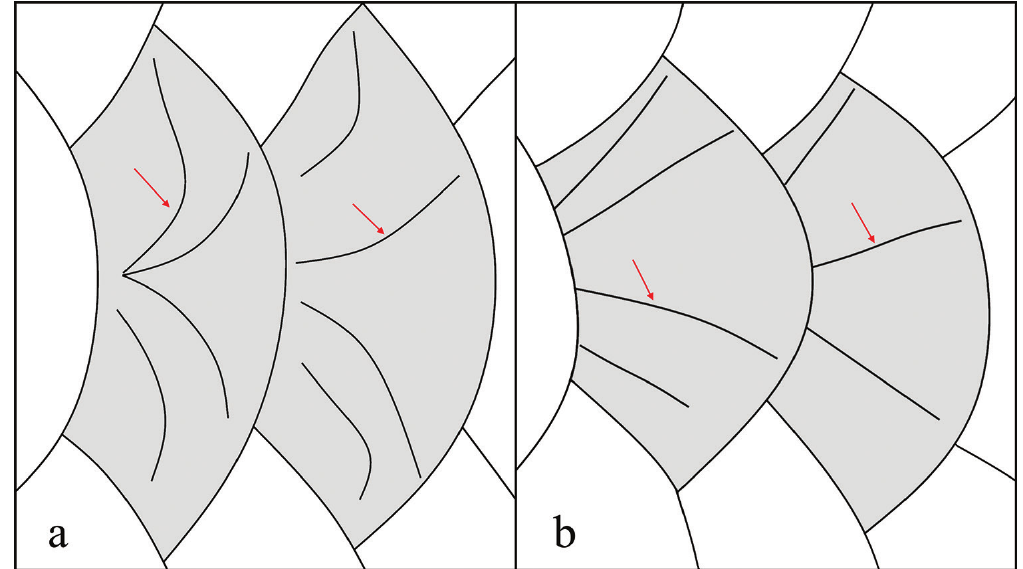
Figure 2. Ilustration of two scales (gray color) with arrows indicating the radii of the scales: a ) Moenkhausia britskii , holotype,